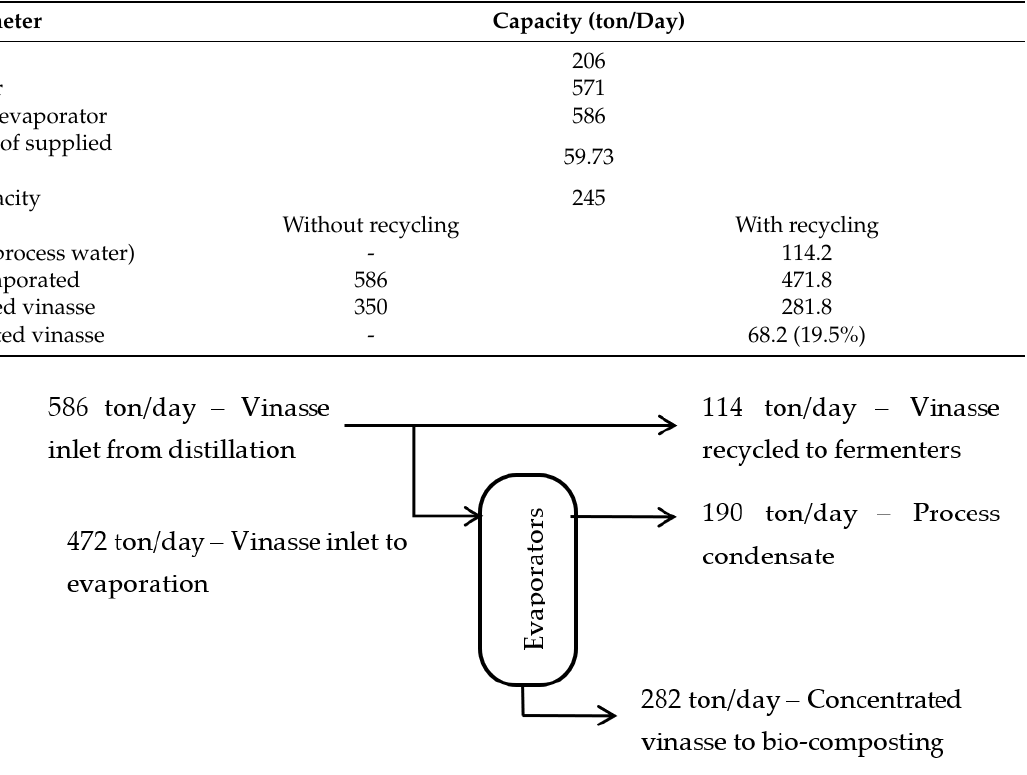
Table 3. Water balance with 20% vinasse recycling.